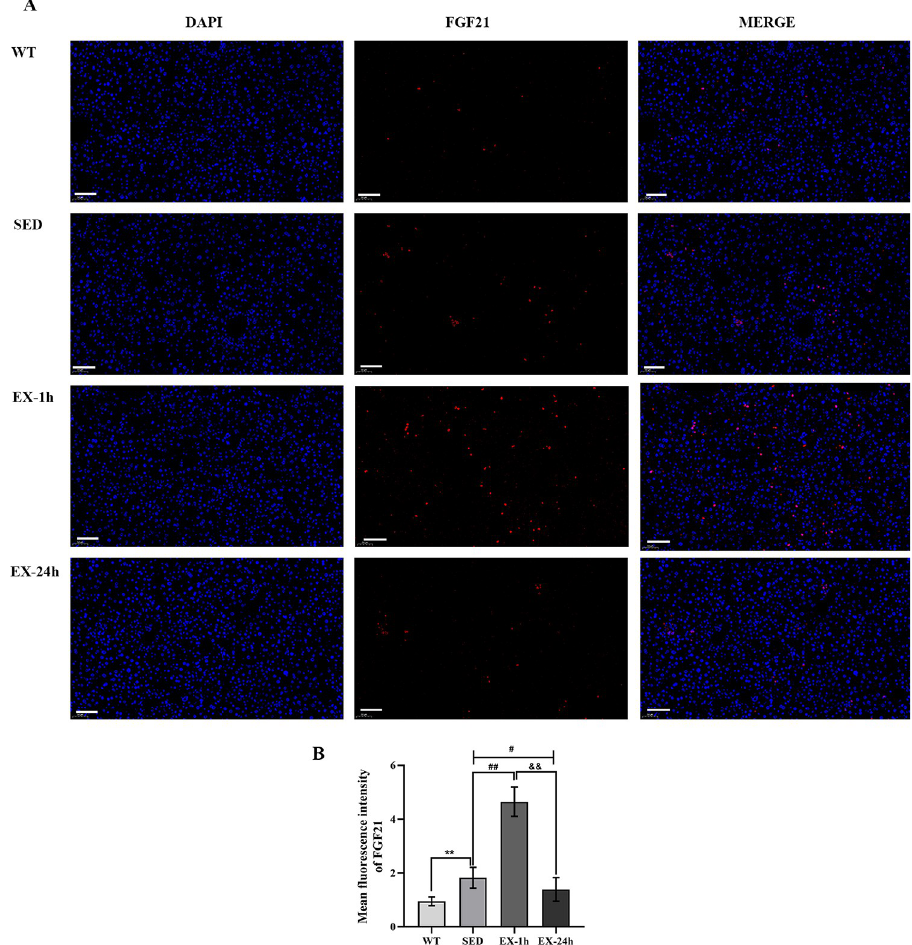
Fig 5. Aerobic exercise activates liver FGF21 protein expression. ( A ) Immunofluorescence detects liver FGF21 protein expression level. Scale bar = 100 μ m. ( B ) Mean fluorescence intensity analysis of FGF21 in liver. The data are expressed as mean ± SD (n = 5, three slices taken from each mouse for staining), �� p < 0.01 vs. WT group; ## p < 0.01 vs. SED group; && p < 0.01 vs. EX-1h